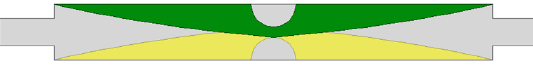
Figure 1: The card that rotates the electric field of 0°. Green trace is on the top of the substrate and the yellow one is on the bottom.